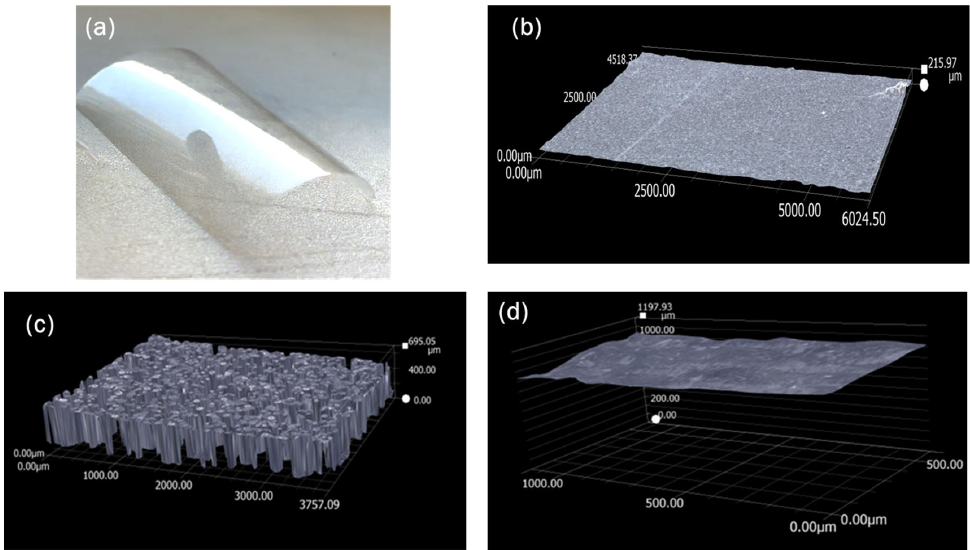
Figure 3. ( a ) Photographic image of solution cast PMMA foils (possibly air voids in sample). ( b – d ) 3D image of commercial foil (purchased from Konig film) and as-prepared